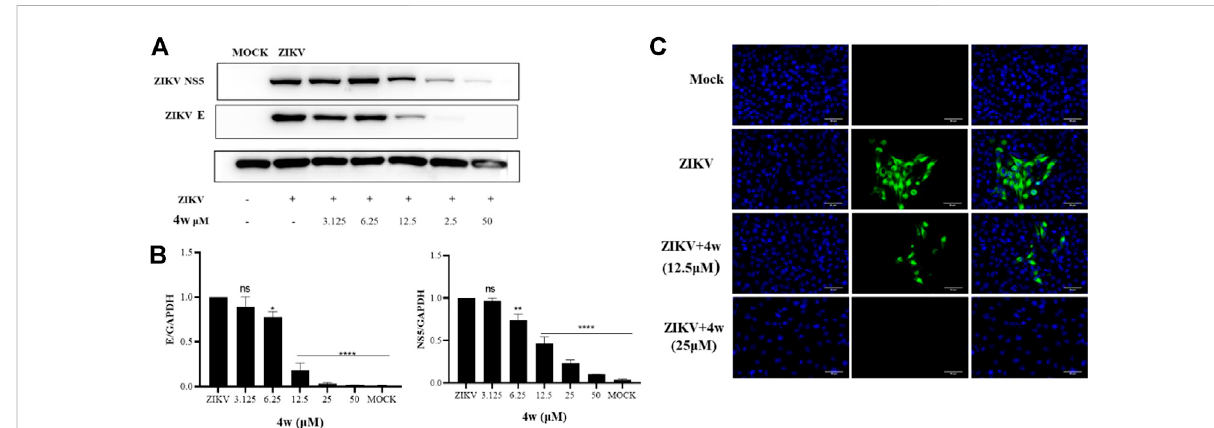
FIGURE 9 Compound 4w inhibited the expression of ZIKV E and NS5 protein. (A) Western blot detected the inhibitory effect of 4w on ZIKV E and NS5 proteinunder the concentration gradient of 4w ; (B) Grayscale analysis and statistics ofthe inhibition of 4w on ZIKV E and NS5 proteinunder the concentration gradient of WB detection; Data is the mean (±SD) of three experiments, with DMSO as a positive contro * p < 0.05; ** p < 0.01; *** p < 0.001; **** p < 0.0001. (C) Detected the inhibitory effect of 4w on ZIKV E protein by immuno fl